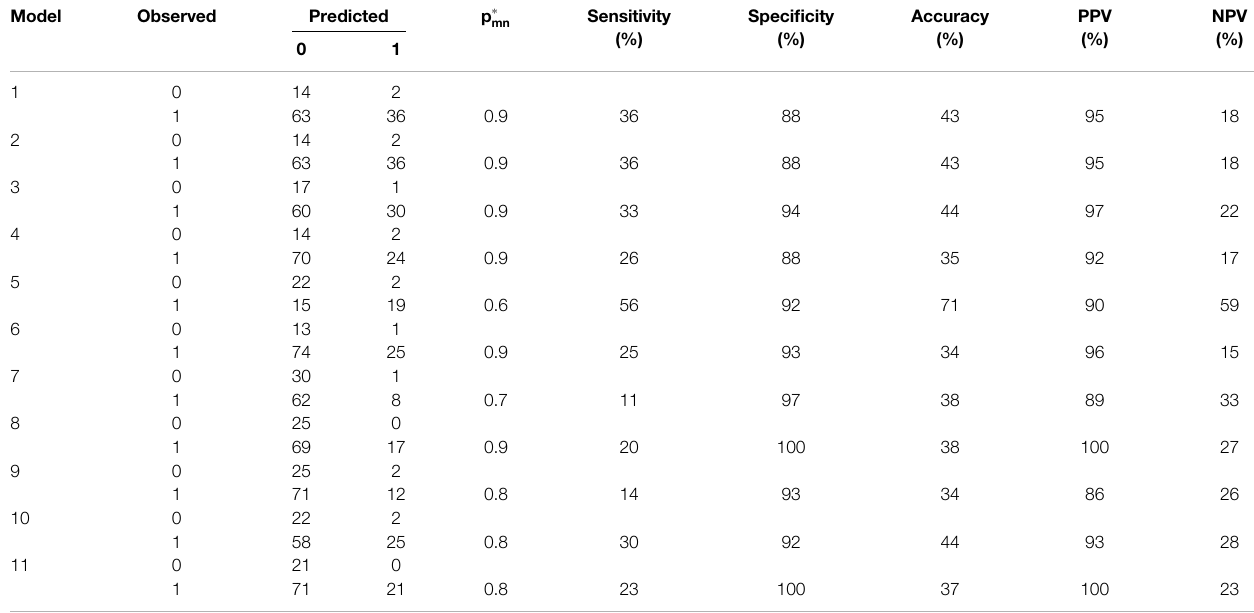
TABLE 8 | Prediction models internal validation